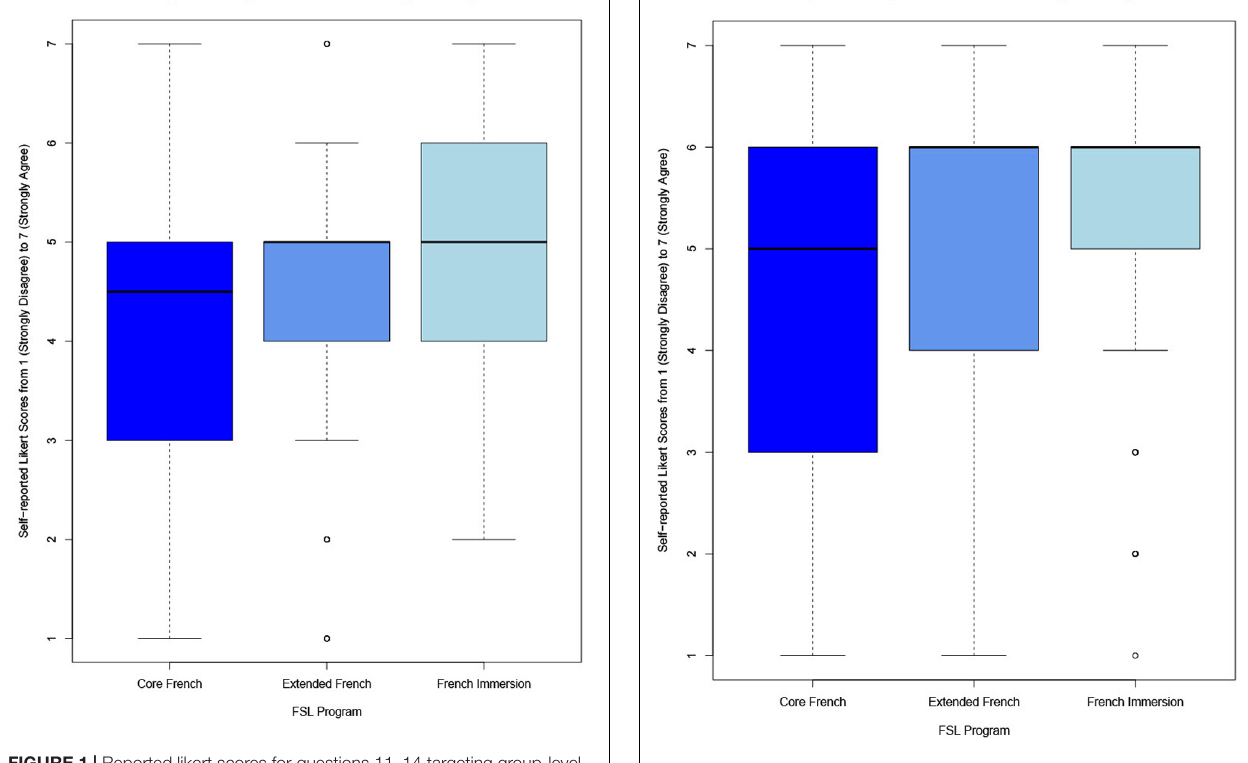
data to support our analyses. This section presents the